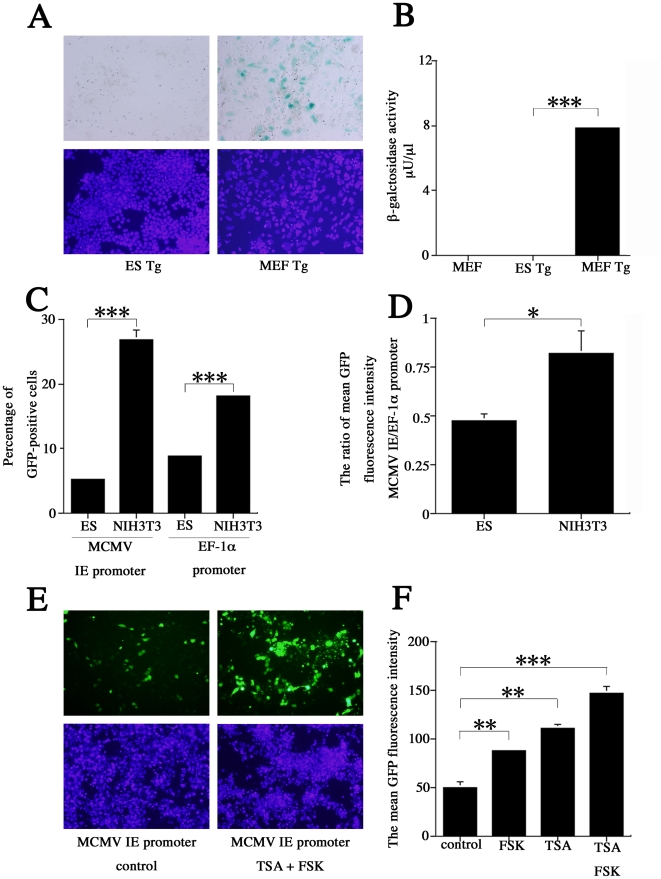
Comparison of transfected/integrated MCMV IE promoter activity in MEF and ES cells.(A) Results of the galactosidase enzyme assay on transgenic ES cells and MEF. β–gal positive cells (blue). (B) β–gal activity in wild-type MEF and transgenic ES cells and MEF. Activity could only be detected in transgenic MEF, at 7.9 µU/µL. (P<0.001) (C, D) Detection of promoter activity by flow cytometric analysis of GFP reporter expression. (C) The percentage of GFP positive cells with MCMV IE promoter activity and EF-1α promoter activity. (D) MCMV IE promoter activity after normalization with EGFP expression values under the control of the EF-1α promoter. There was a significant difference between ES and NIH3T3 after normalization (P<0.05). (E, F) Examination of the influence of histone modification and stimulation of the cAMP pathway on the transfected MCMV IE promoter in ES cells. (E) Co-treatment with FSK and TSA drastically increased the number of GFP-positive cells. (F) FSK and TSA each increase GFP fluorescence activity when administered individually (FSK: P<0.01, TSA: P<0.01), but the strongest response was seen when they were administered together (P<0.001). All presented experiments were performed at least 3 times, and data are given as the mean±SD. * P<0.05, ** P<0.01, *** P<0.001, t-test.